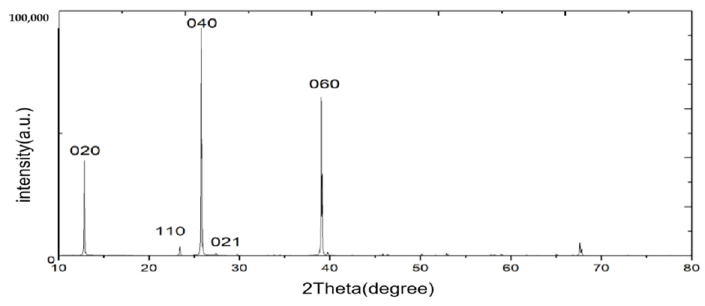
Figure 10. XRD spectrogram of the products from DCLR (ER) -MoS 2.